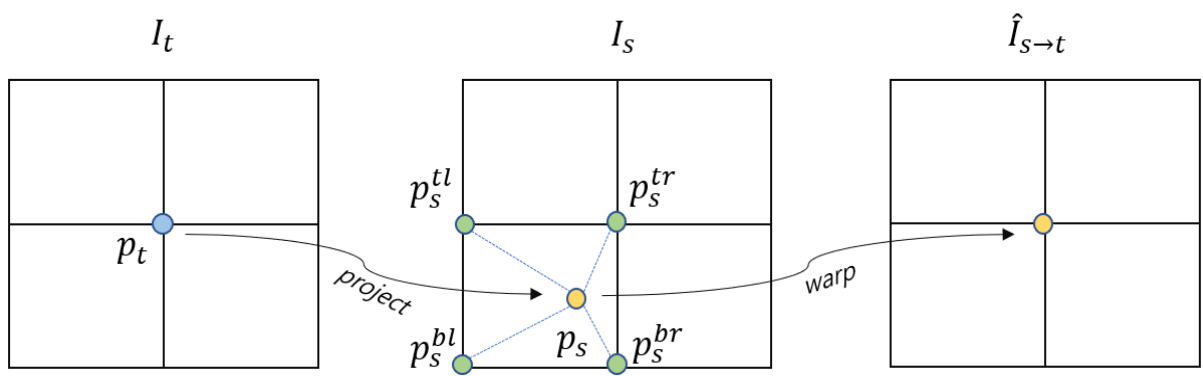
Figure 3. Bilinear sampling process. This is the process of projecting each point p t of target image I t to the source image I s , and inputting a pixel value obtained by interpolating the surrounding pixels of the projected point into p t of ˆ I s → t . As a result, the image ˆ I s → t at the viewpoint I t is synthesized from I s .